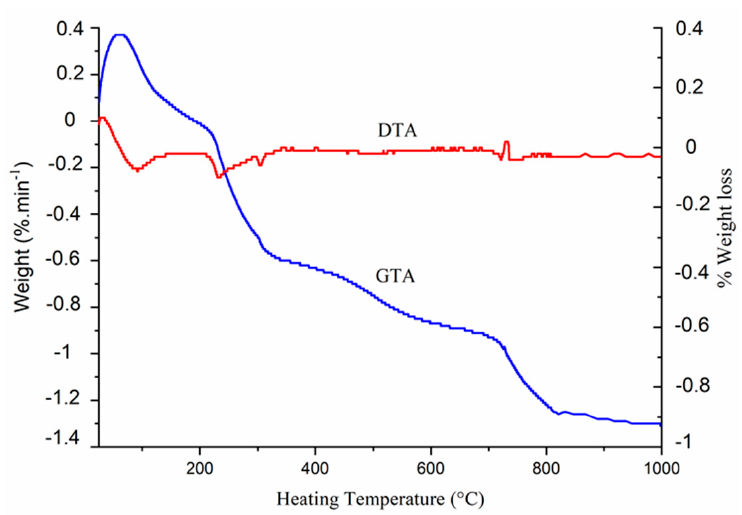
Figure 4. Differential thermal (left Y -axis) and thermogravimetric (right Y -axis) analyses of synthesized Ca 9.5 K 0.5 (PO 4 ) 6 (OH) 0.5 F sample.